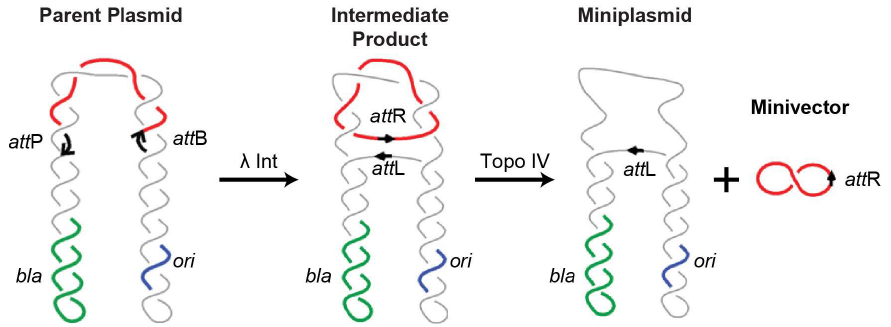
Figure 1. Generation of DNA minivectors. To generate minivectors, any target sequence or expression cassette is cloned between the att B and att P sites located in direct orientation in a minivector-producing parent plasmid. λ integrase mediates the intramolecular recombination of the att B and att P sites, producing two catenated rings: the minivector containing the target sequence or expression cassette, and a miniplasmid containing all the other undesired sequences. The catenanes are unlinked by topoisomerase IV. λ Int: lambda integrase; Topo IV: topoisomerase IV; bla : β lactamase (encoding ampicillin resistance); ori : bacterial origin of replication; att P: phage attachment site; att B: bacterial attachment site; att L: hybrid attachment site to the "left" of the recombined sequence; att R: hybrid attachment site to the "right" of the recombined sequence.